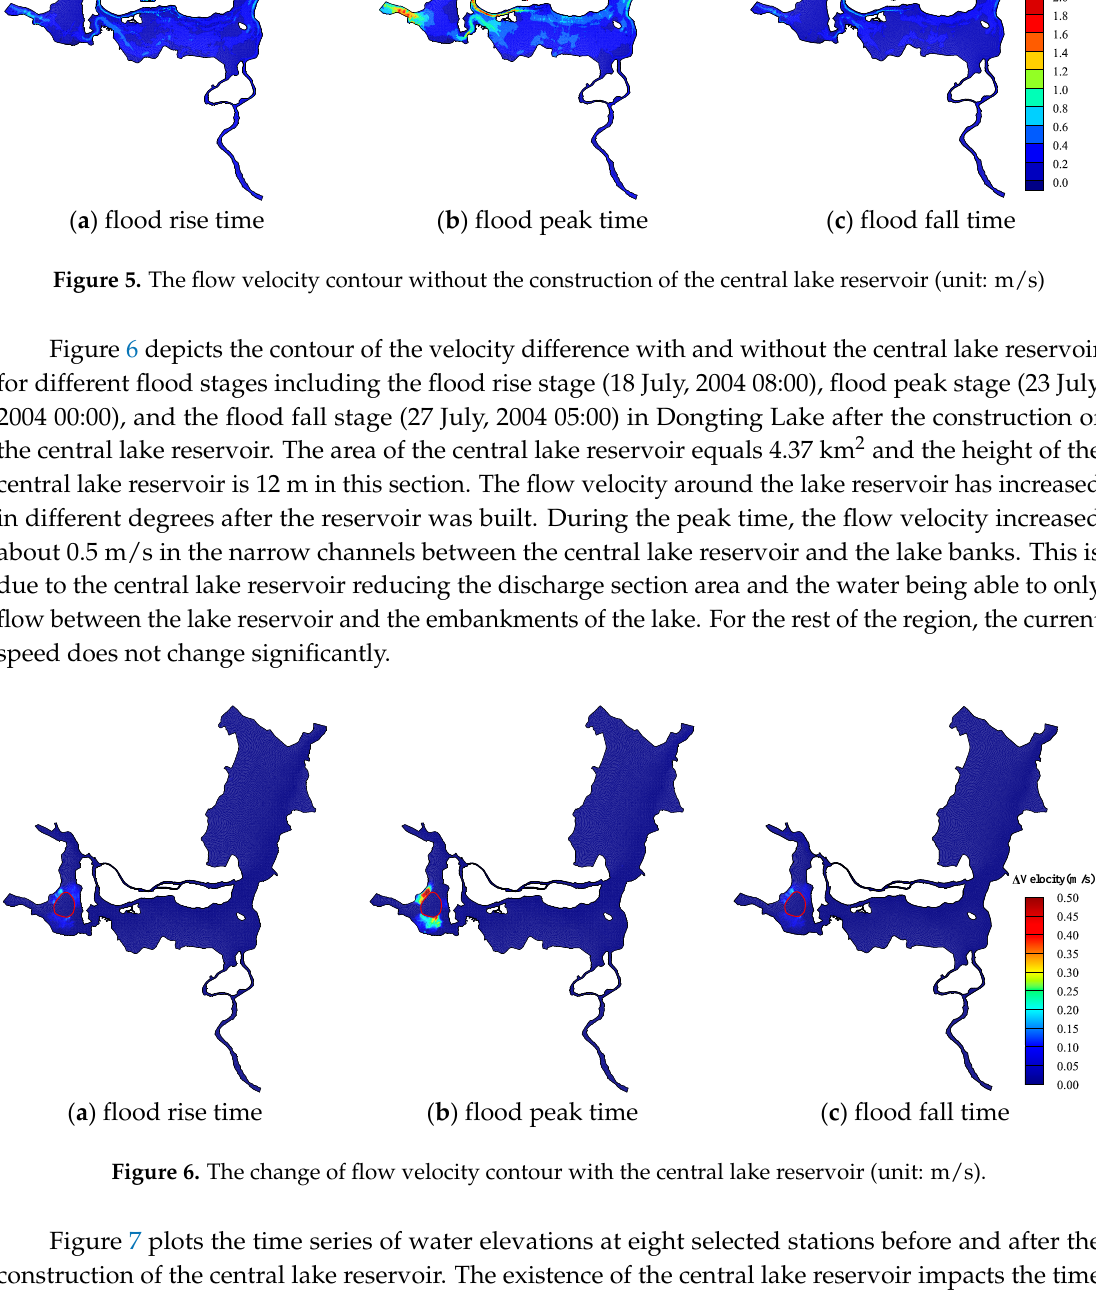
Figure 6. The change of flow velocity contour with the central lake reservoir (unit: m/s).